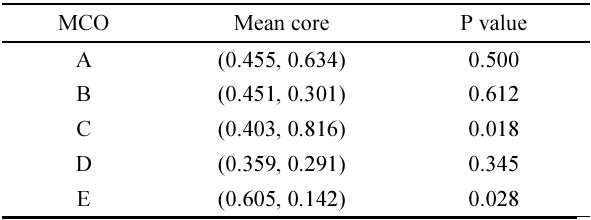
Table 11. The Difference in Production Efficiency and